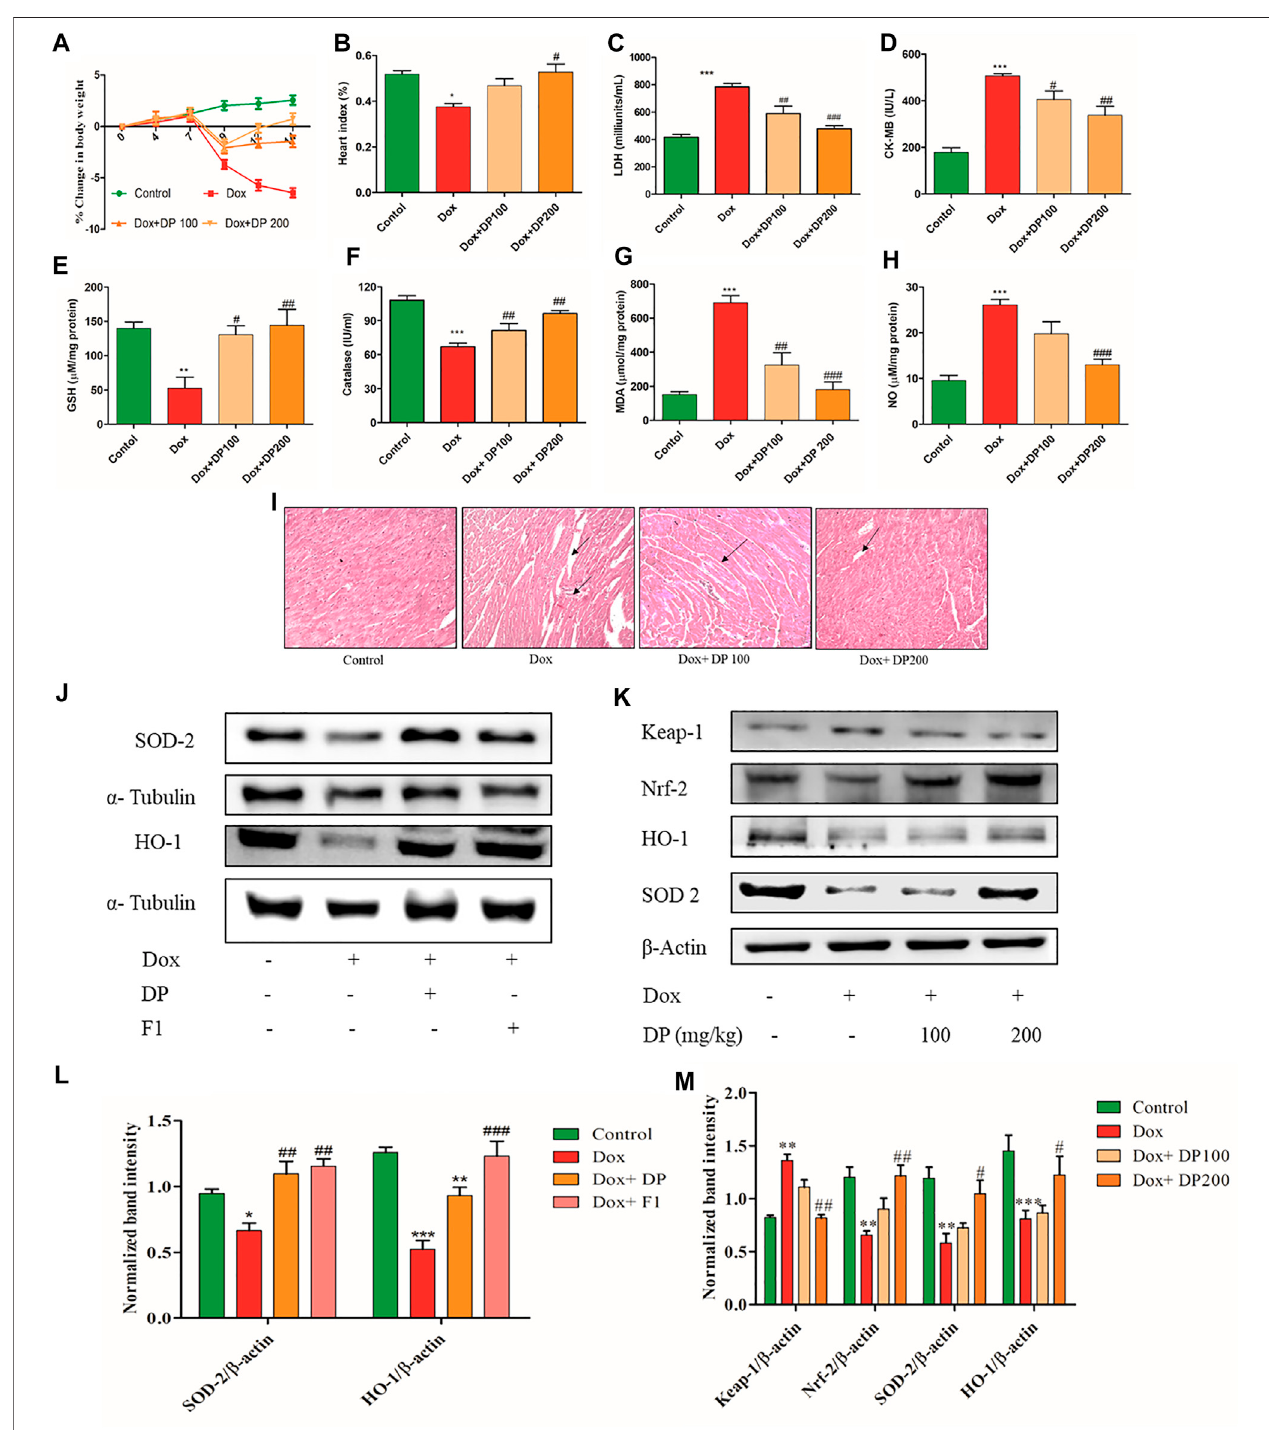
FIGURE 5 | Effect of DP extract on (A) percentage change in body weight (B) Heart index (C) LDH (D) CK-MB (E) GSH (F) catalase (G) MDA and (H) Nitric oxide, where n (cid:2) 5. (I) Histopathology H&E staining of cardiac tissue. (J) In-vitro western blot analysis of protein levels of SOD-2 and HO-1 in H9c2 cell line (K) In-vivo western blot analysisofSOD-2,Keap-1, Nrf-2,and HO-1. (L) Quantitative analysisofrelative protein levels ofSOD-2andHO-1. (M) Quantitativeanalysisofrelativeprotein levels of KEAP-1, Nrf-2 SOD-2, and HO-1 expression respectively. The data were analyzed by One Way ANOVA and Two Way ANOVA using Graph Pad Prism. *** p < 0.001, ** p < 0.01, * p < 0.05 represents normal control vs disease control (Dox). # p < 0.05 ## p < 0.01 and ### p < 0.001 represents disease control (Dox) vs treatment groups ( n (cid:2) 3).